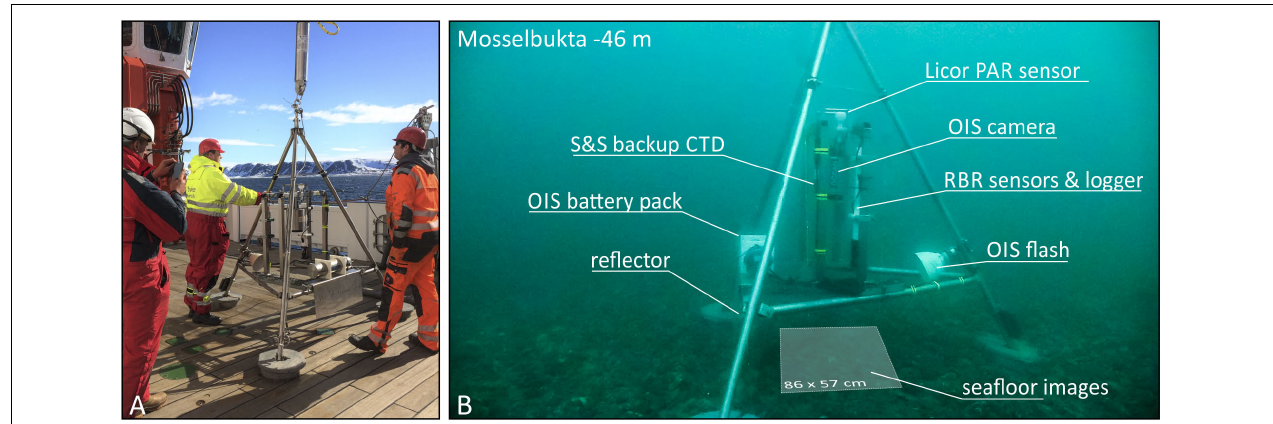
FIGURE 2 | (A) The SaM Lander on board RV Maria S. Merian ready for deployment via winch and acoustic release in June 16th, 2016 in Mosselbukta, Svalbard. (B) The lander and its components photographed with ambient light, sitting on the rhodolith bed at 46 m water depth in Mosselbukta.